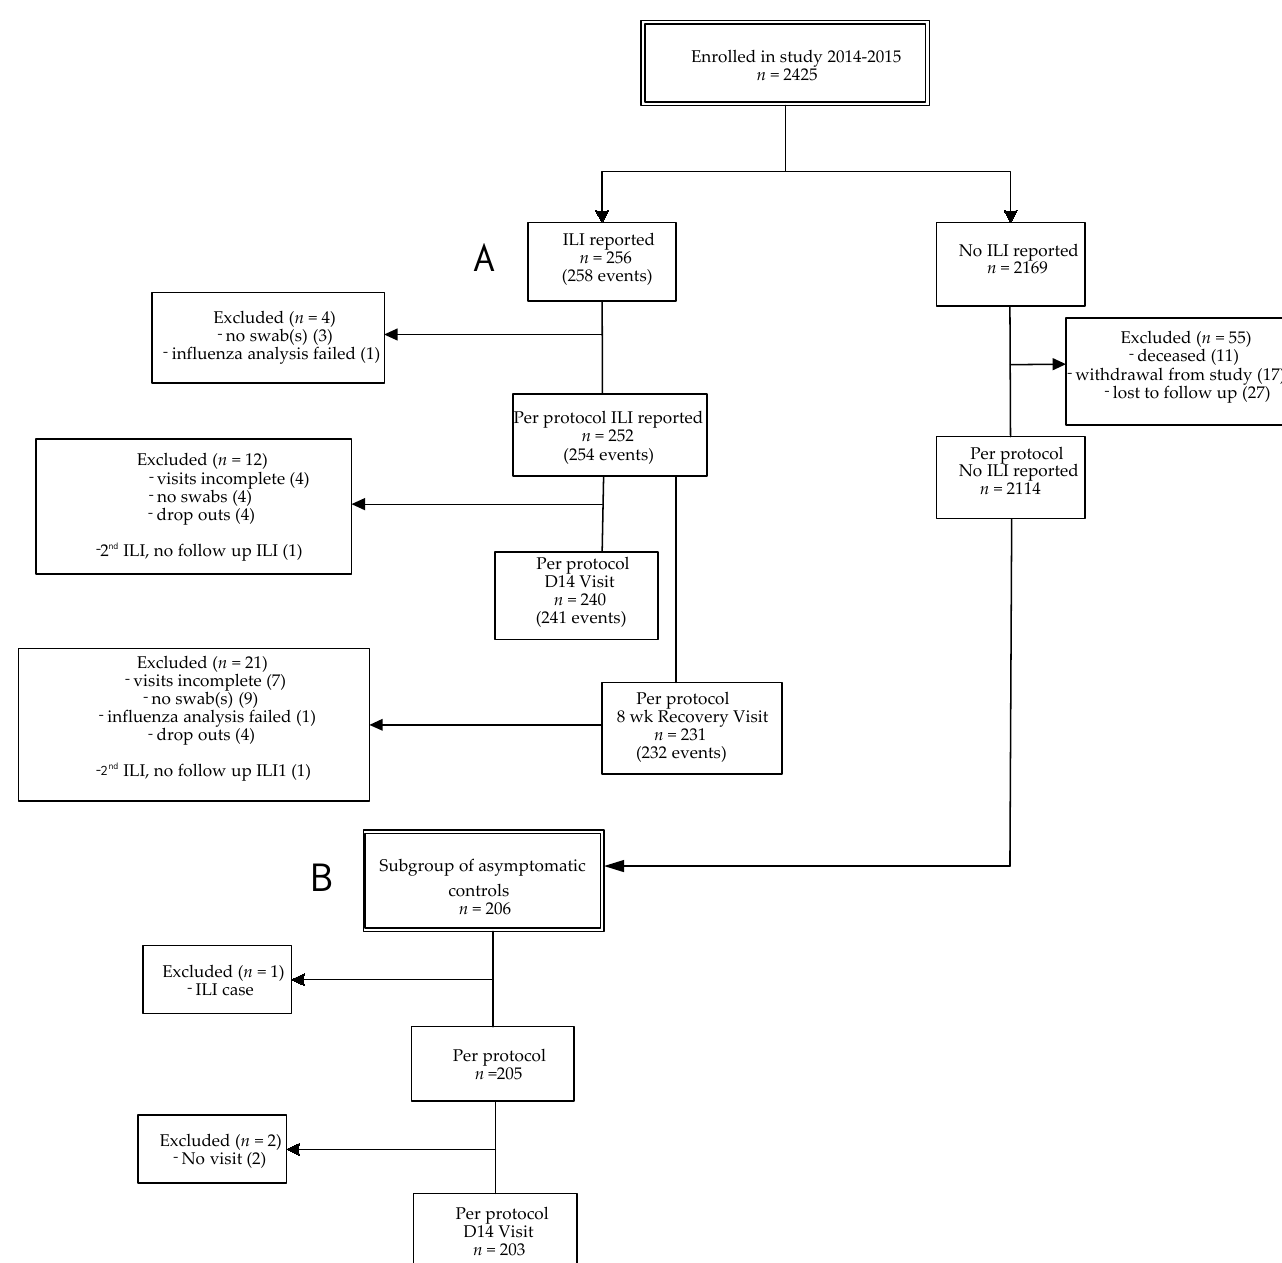
Figure 1. Flow diagram of enrollments. Influenza-like illness (ILI) cases (2014–2015) ( A ) and the subgroup of asymptomatic controls ( B ). A subject could have multiple ILI episodes per season. Per protocol was defined when the sample was taken <72 h after start of fever. For the recovery visit, the window was 7–9 weeks after ILI onset. Subjects were considered lost to follow-up if they did not respond to the end of study mailing and had no ILI visit. Every month of the study period a fixed number of asymptomatic participants, equally distributed over the different age groups, were invited for swab